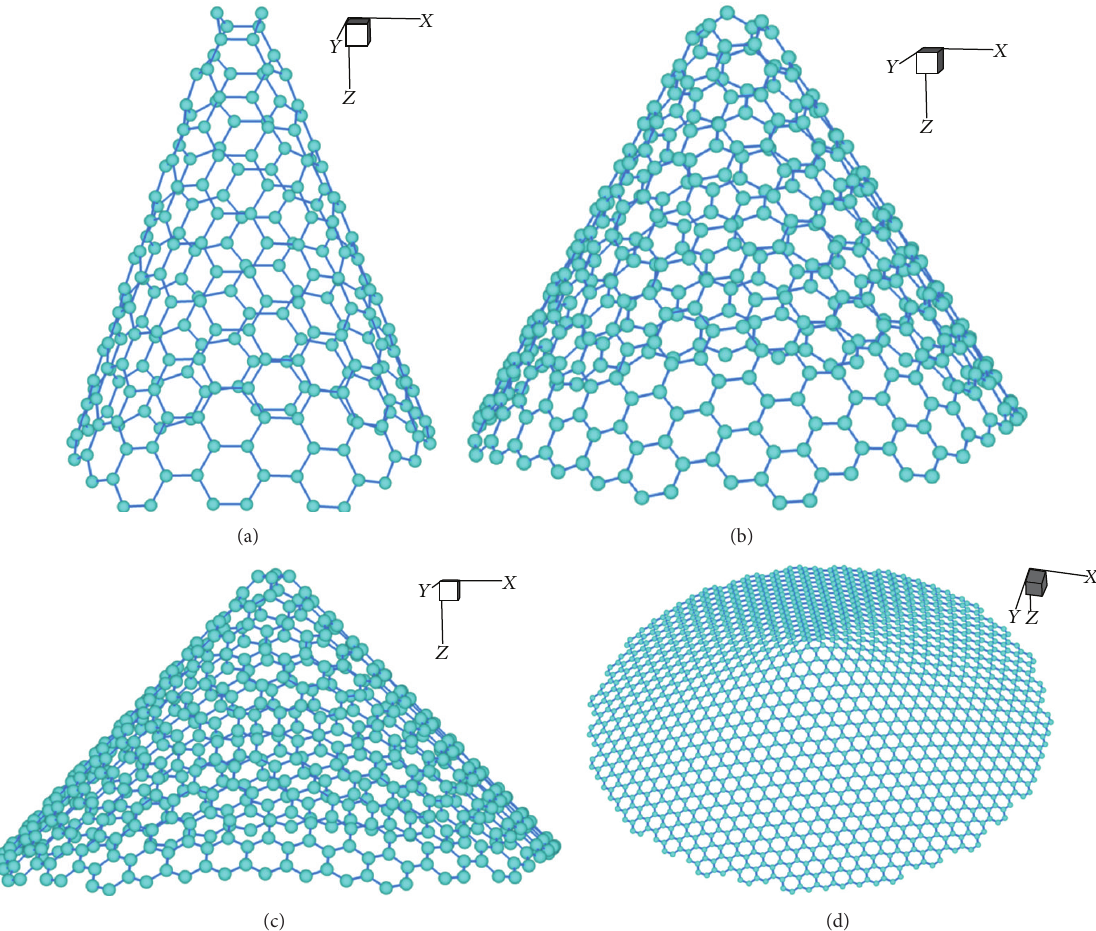
Figure 3: Cones with apex angles of (a) 38.9 ∘ , (b) 60 ∘ , (c) 86.6 ∘ , and (d) 123.6 ∘ , with cone heights of 20 ˚A.